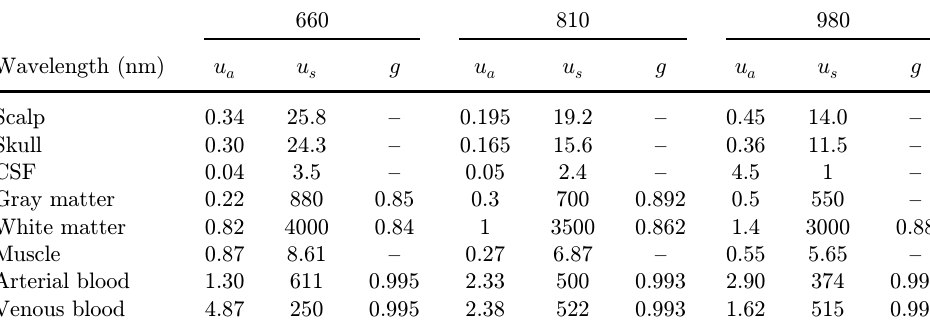
Table 1. Optical properties of head tissues for 660-nm, 810-nm and 980-nm light. 25 – 28 The units of both absorption coe±cient ( u a Þ and scattering coe±cient ( u s Þ are cm (cid:2) 1 . Those tissue types having no anisotropic factor ( g ) value in the table denoted that their g was set as 0.9 in default.